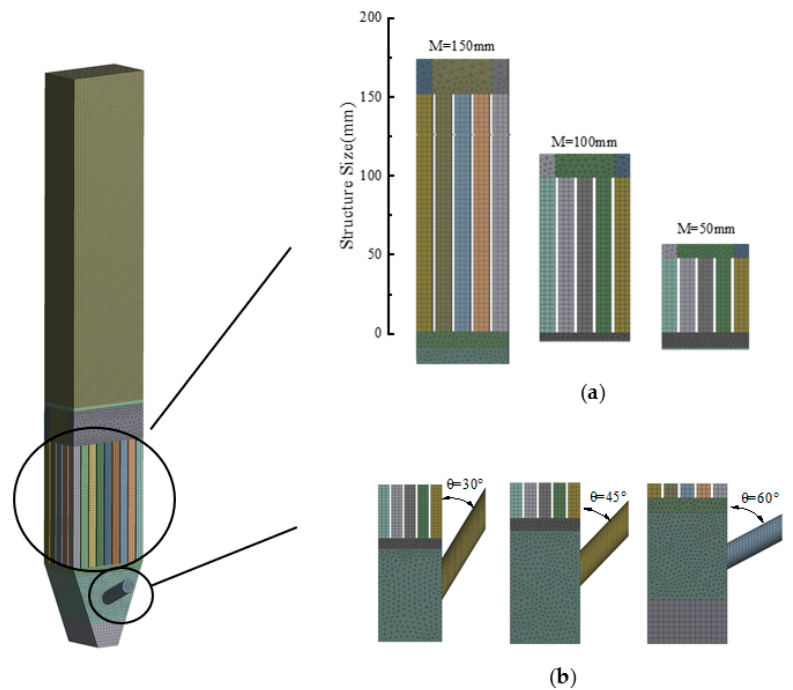
Figure 3. Grids of different structures. ( a ) Grids corresponding to different lengths of the TES. ( b )